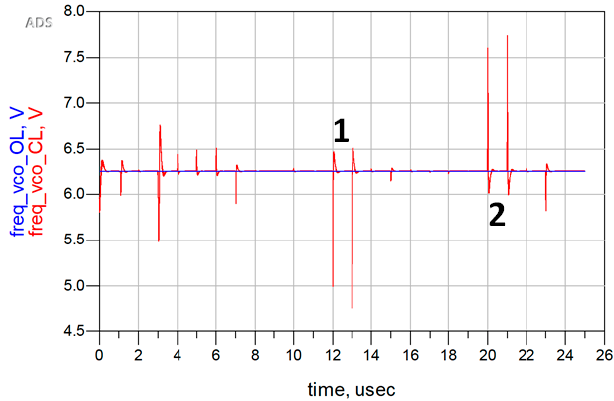
Figure 18. Output frequency of the ADS PLL model as function of time, for Single Event Transients (SETs) spaced 1 µs apart, hitting every sensitive node of the CP and with a Linear Energy Transfer (LET) of 60 MeV ∙ cm 2 /mg.